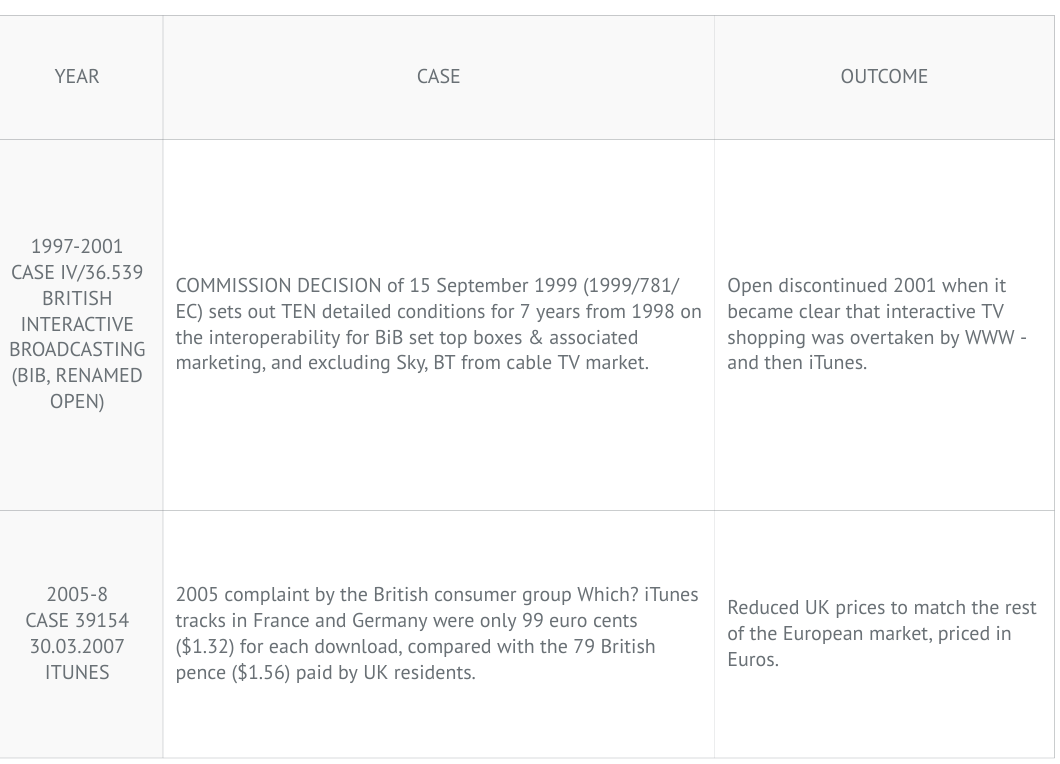
TABLE 1: App Store & Associated European Competition Cases